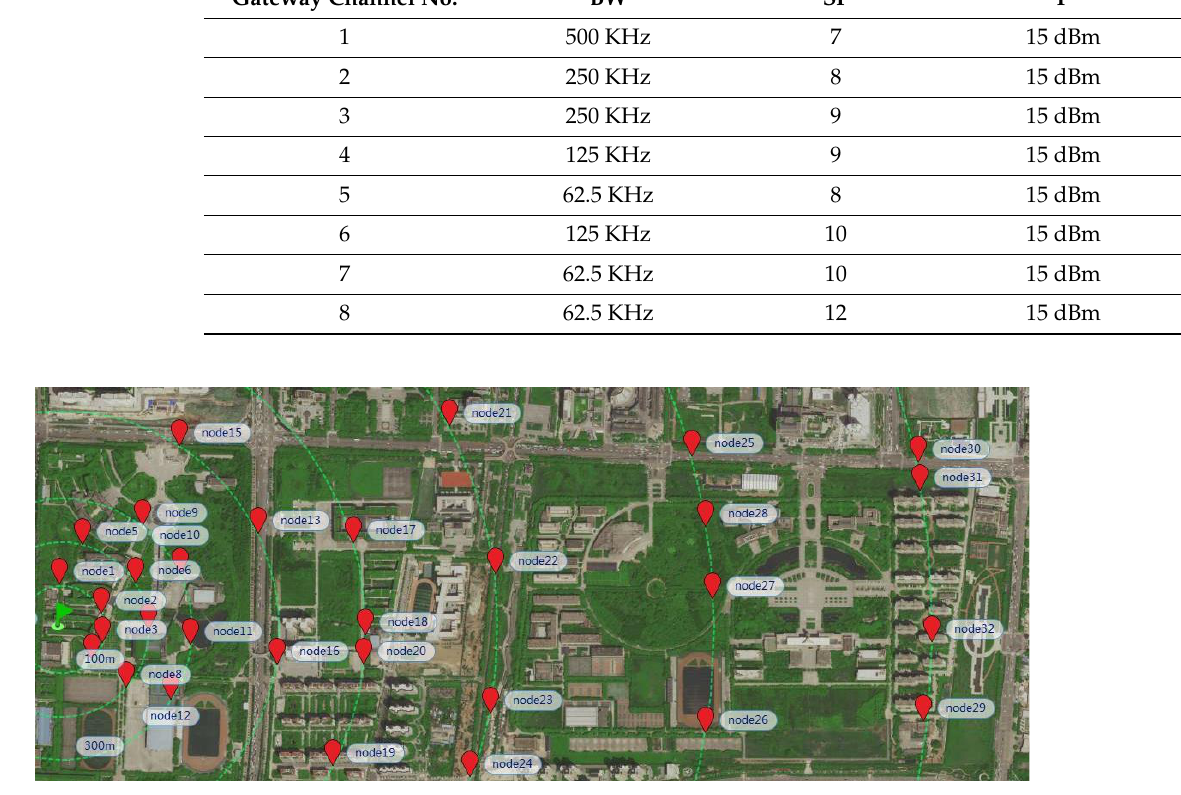
Table 8. Gateway channel parameter configuration. Gateway Channel